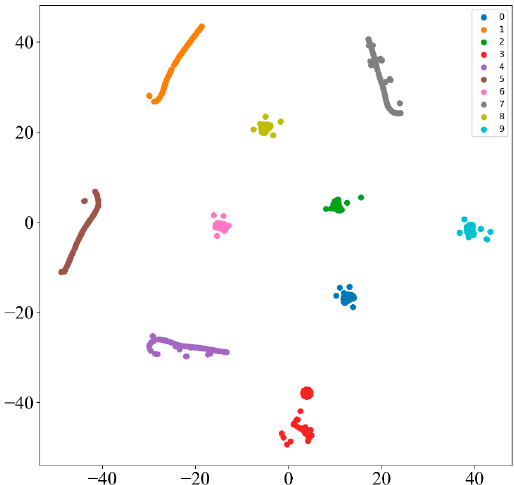
Figure 5. Accuracy rate of various types of fault identification in the testing set.